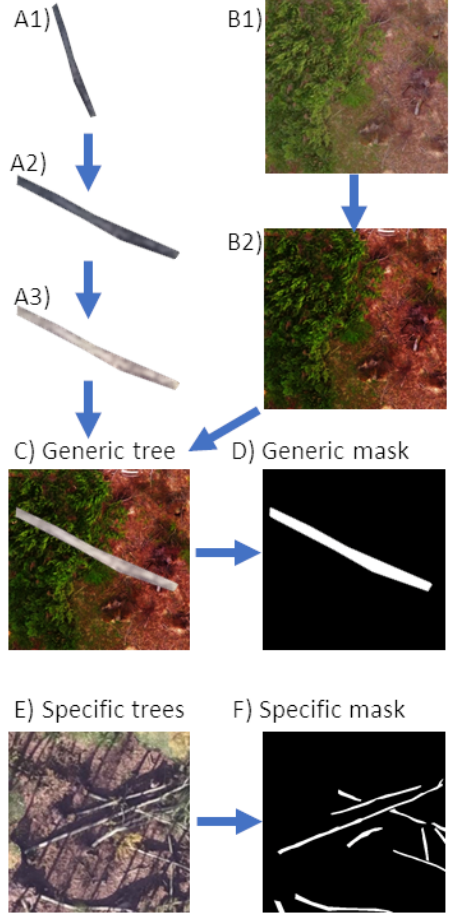
Figure 3. Schematic illustrations of the augmentation process of the generic training dataset. The clipped tree ( A1 ) is manipulated with random morphological transformations ( A2 ) and manip- ulations of the pixel values ( A3 ). The same filters are applied to the background samples ( B1 , B2 ) before both were combined into a generic tree sample ( C ). Finally, the training mask was calculated ( D ). Furthermore, for the specific windthrow samples ( E ), stem masks were are generated ( F